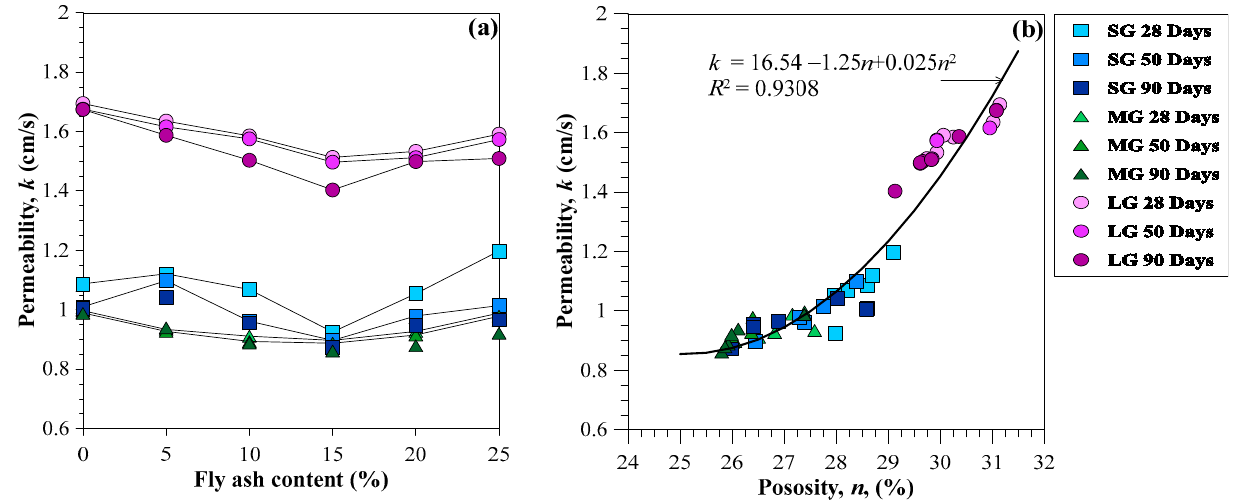
Figure 10. Relationships between ( a ) permeability coefficient and fly ash content and ( b ) permeability coefficient porosity.